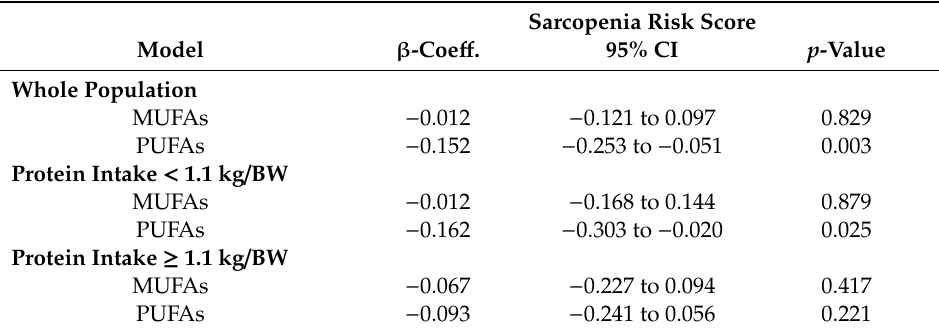
Table 4. E ff ect of the isocaloric substitution of saturated fatty acids by unsaturated fatty acids on sarcopenia risk score in the whole population of older European adults and stratified by meeting the recommendation of 1.1 g / BW of protein intake. β -Coe ff